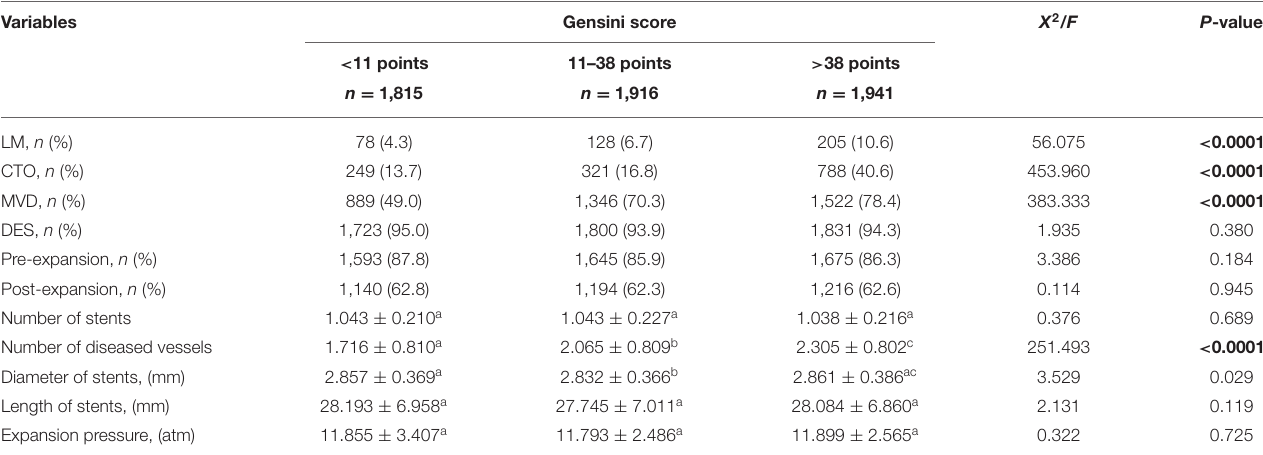
TABLE 2 | Procedural characteristics of patients in the total